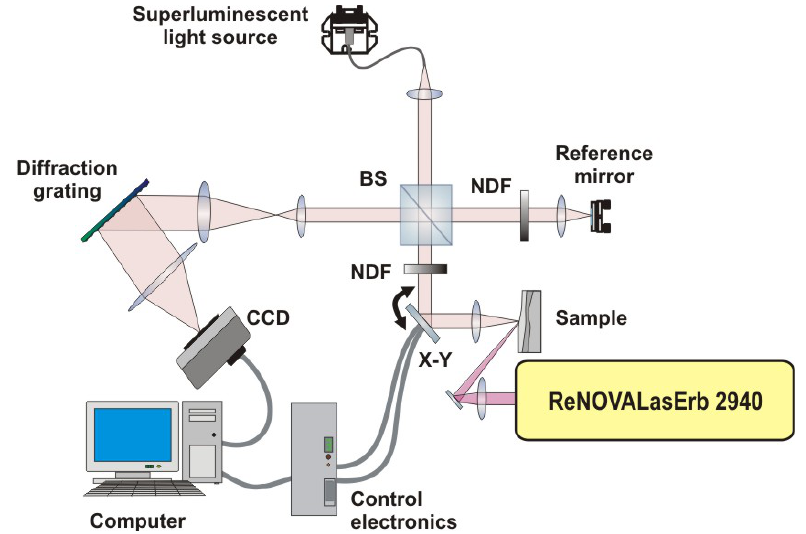
Figure 14. Diagram of the SOCT instrument used in the study: BS—beam splitter, NDF— neutral density filter, CCD – CCD linescan camera, X-Y – galvanometric